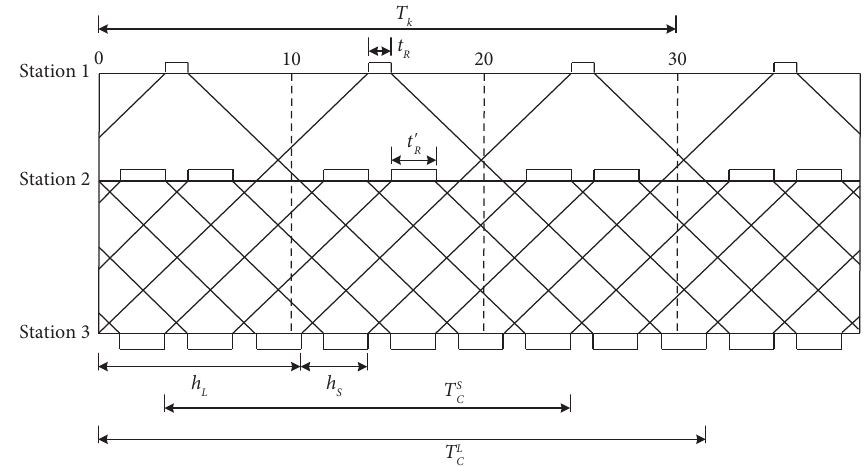
Figure 2: Schematic train diagram of the long-short route.